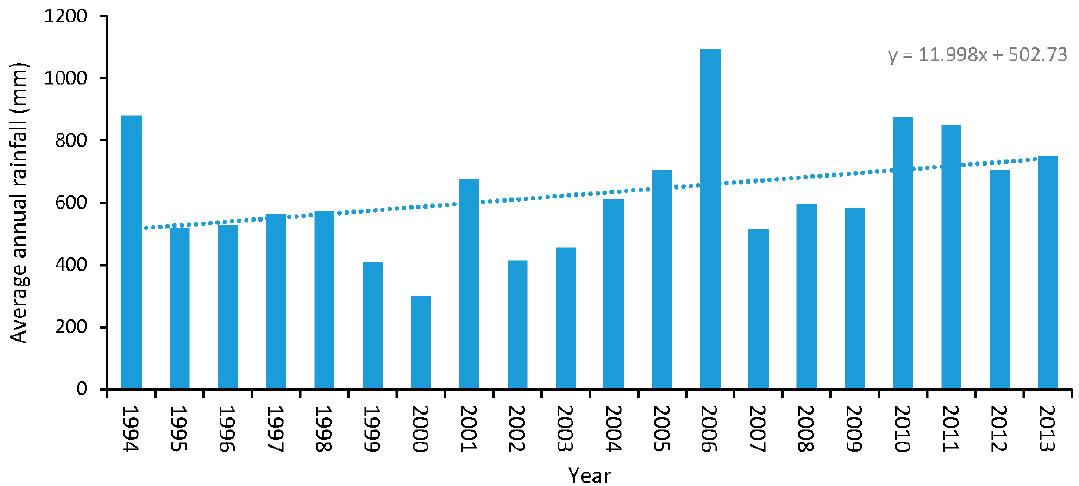
Figure 4. Rainfall hyetograph for Udaipur district of Rajasthan from 1994 to 2013.